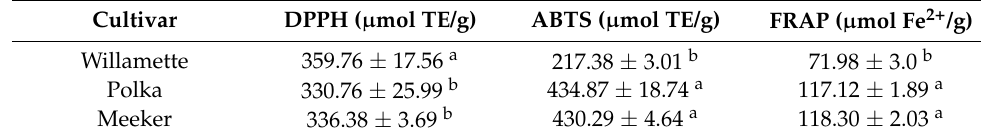
Table 5. Antioxidant activity of the polyphenolic extracts of all the examined raspberry varieties, obtained using UAE under optimal conditions.